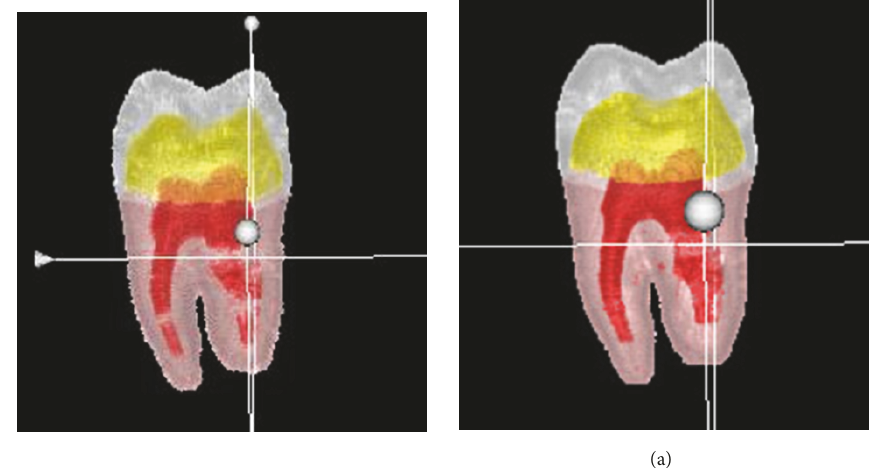
Figure 5: Rendering result of MLP augmented tooth dataset with two methods: (a) rendering result based on region criteria based method and (b) rendering result based on depth enhanced